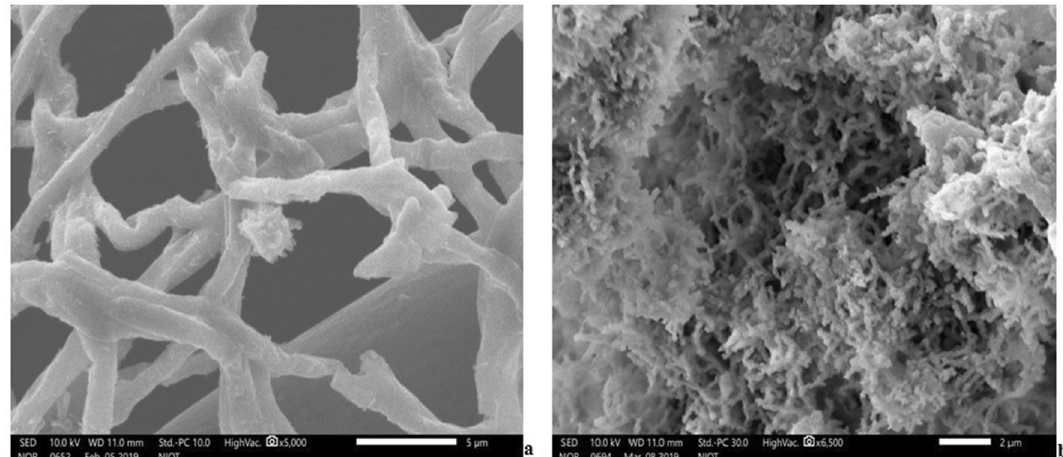
Figure 3. A. sydowii BOBA1 observed during degradation of SE oil by SEM. ( a ) Cells at 0.1 MPa. ( b ) Cell clusters at 10 MPa.